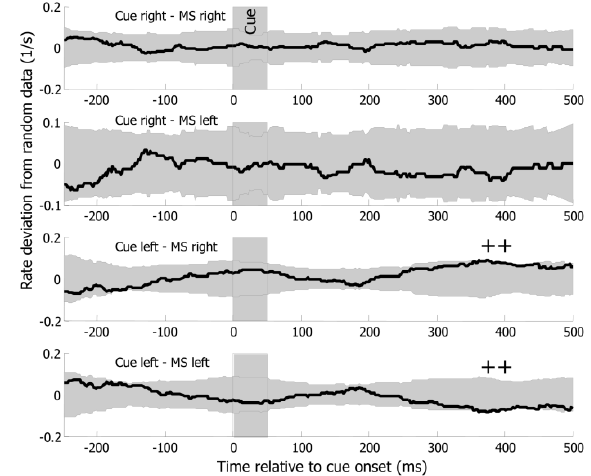
Figure 6. The modulation of horizontal microsaccade rates during fixation in an auditory non- -predictive cue-target task. The rate deviation of left and right microsaccades from randomized data during left and right cues is plotted. This figure was created using the same analysis as in Fig. 3.